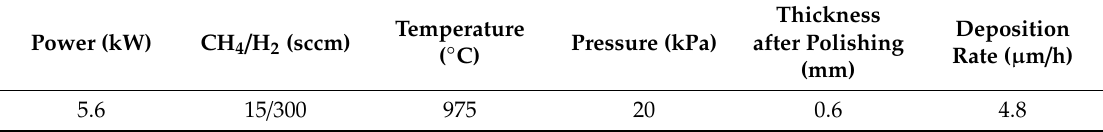
Table 1. Deposition conditions, growth rate, and dimension of diamond film sample.